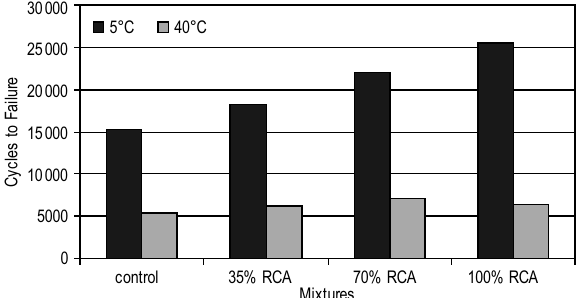
Fig. 3. Number of cycles required for failure vs. mixtures with different RCA contents for gradation type